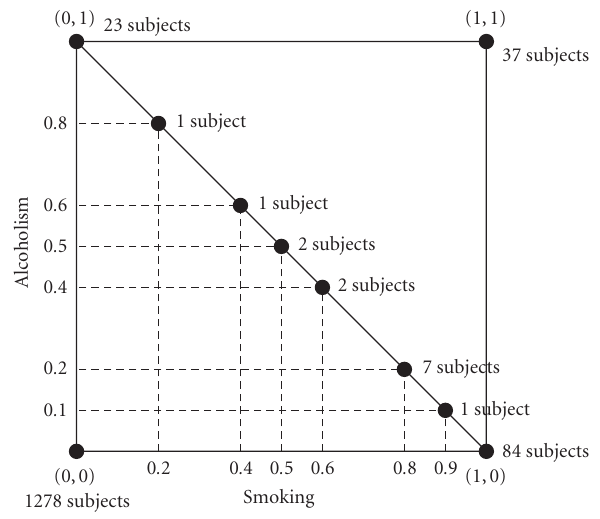
Figure 2: Number of subjects in the two-dimensional fuzzy hyper- cube I 2 .